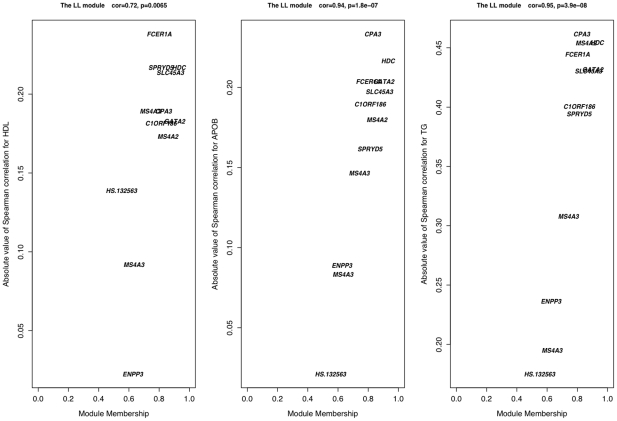
Connectivity and trait association within the LL module.In the LL module, there is a strong positive correlation between the intra-modular connectivity of a node (gene) and its association with APOB, HDL, and TG levels, showing that the approximately eight genes inter-connected are also the most associated with lipid traits. These genes constitute the core of the LL module.